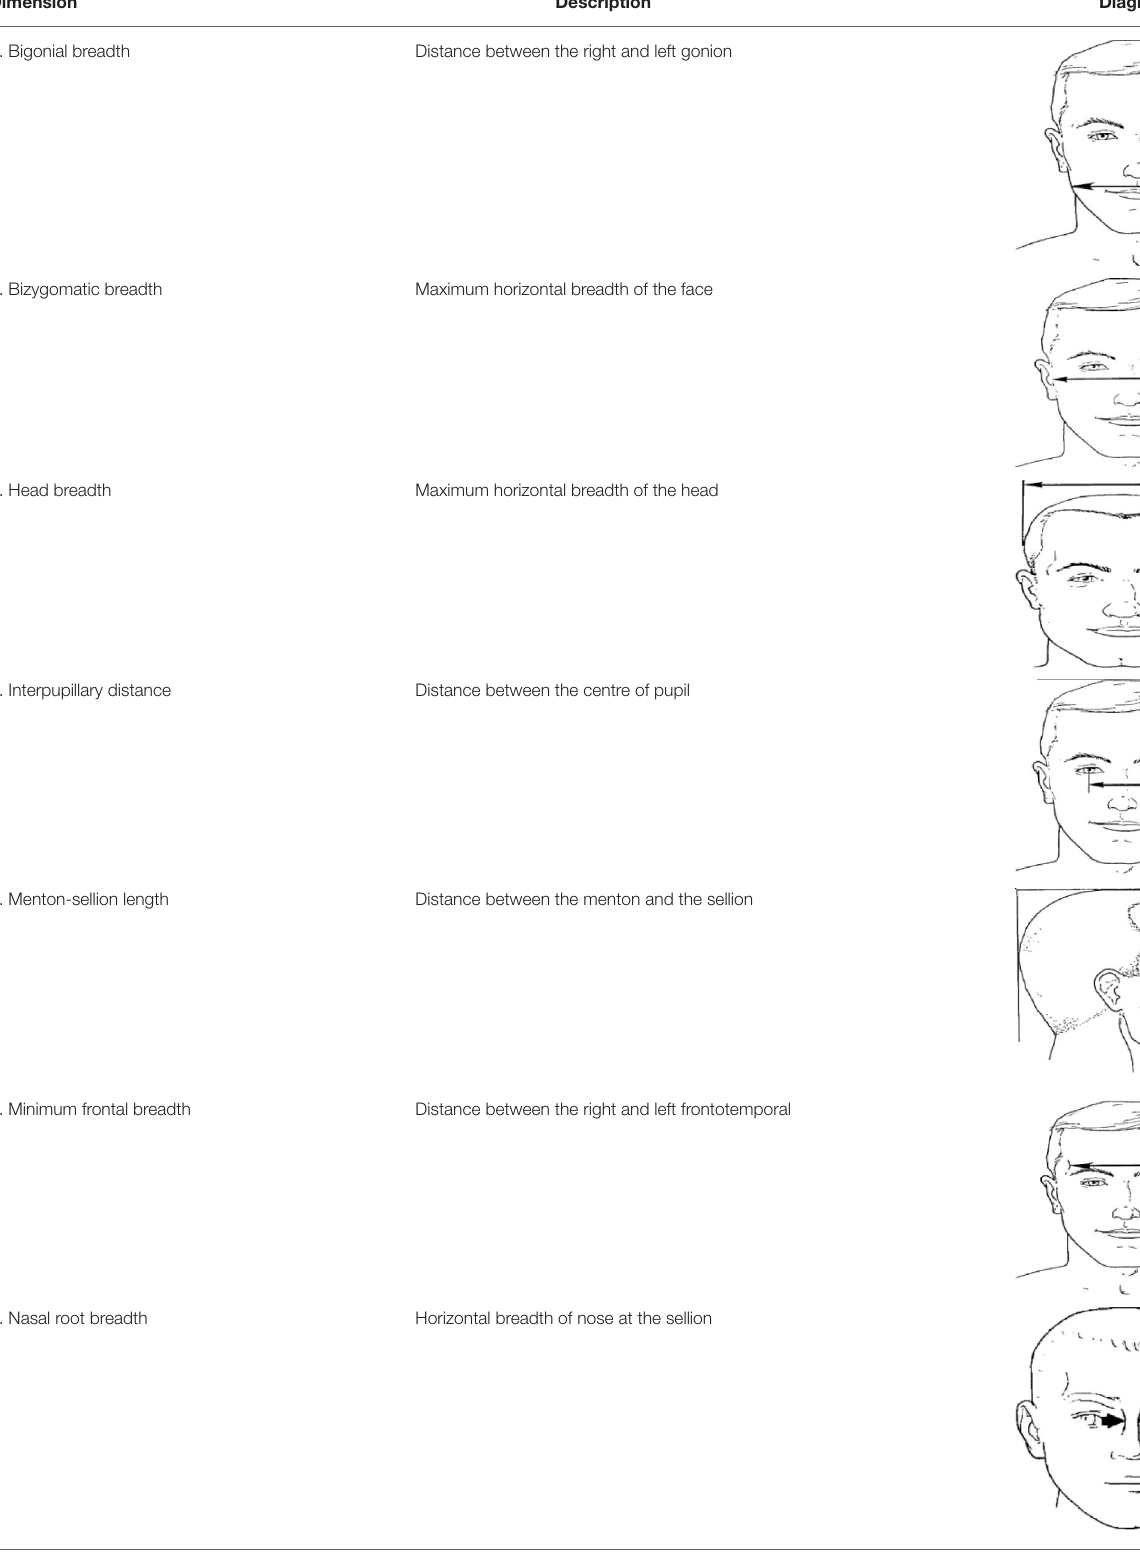
TABLE 1 | Description, definition, and diagram of measurements (30). Dimension Description